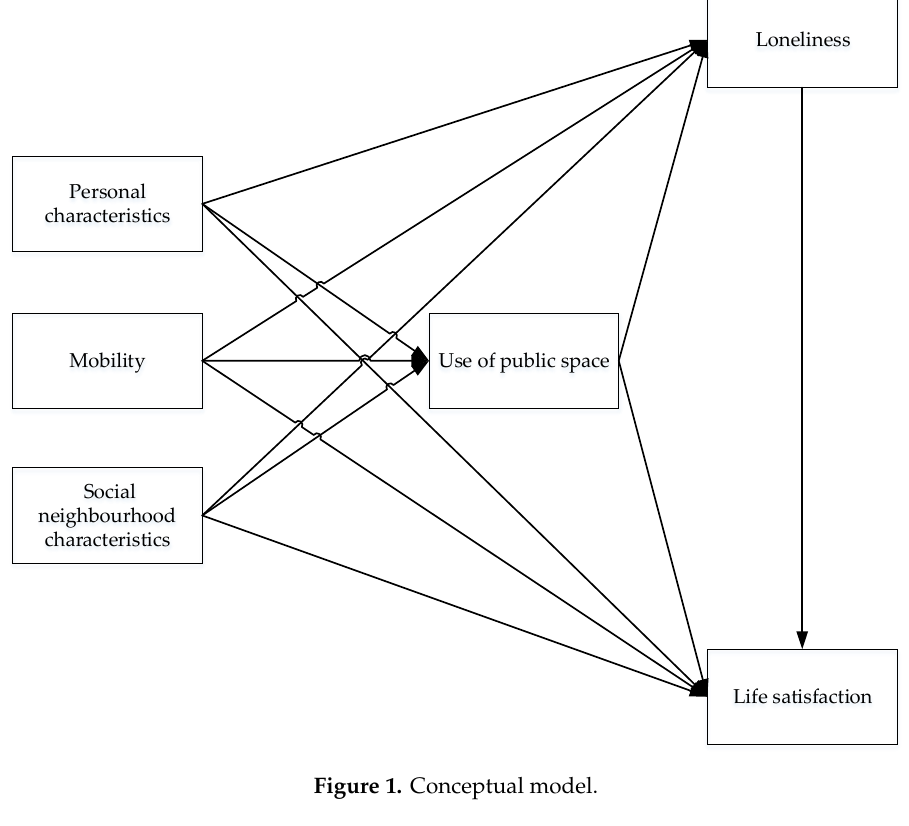
Figure 1. Conceptual model .